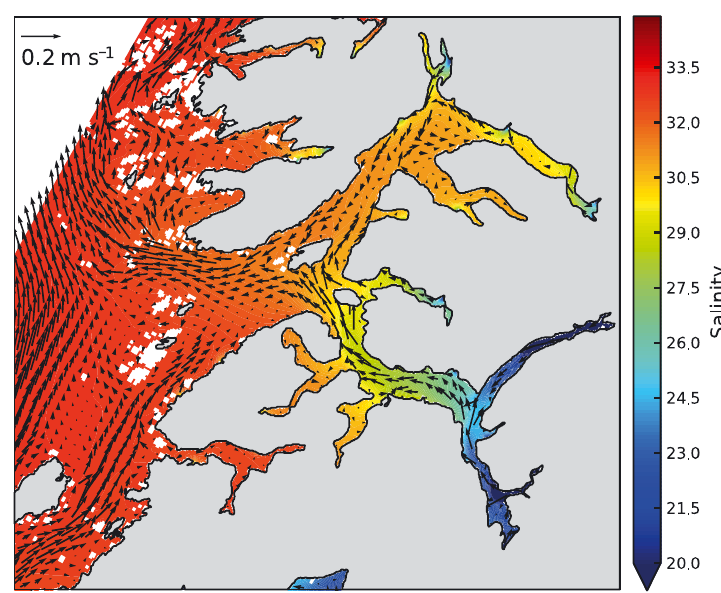
Fig. 2. Surface salinity and current vectors showing average values for the simulation period (1 April to 31 August